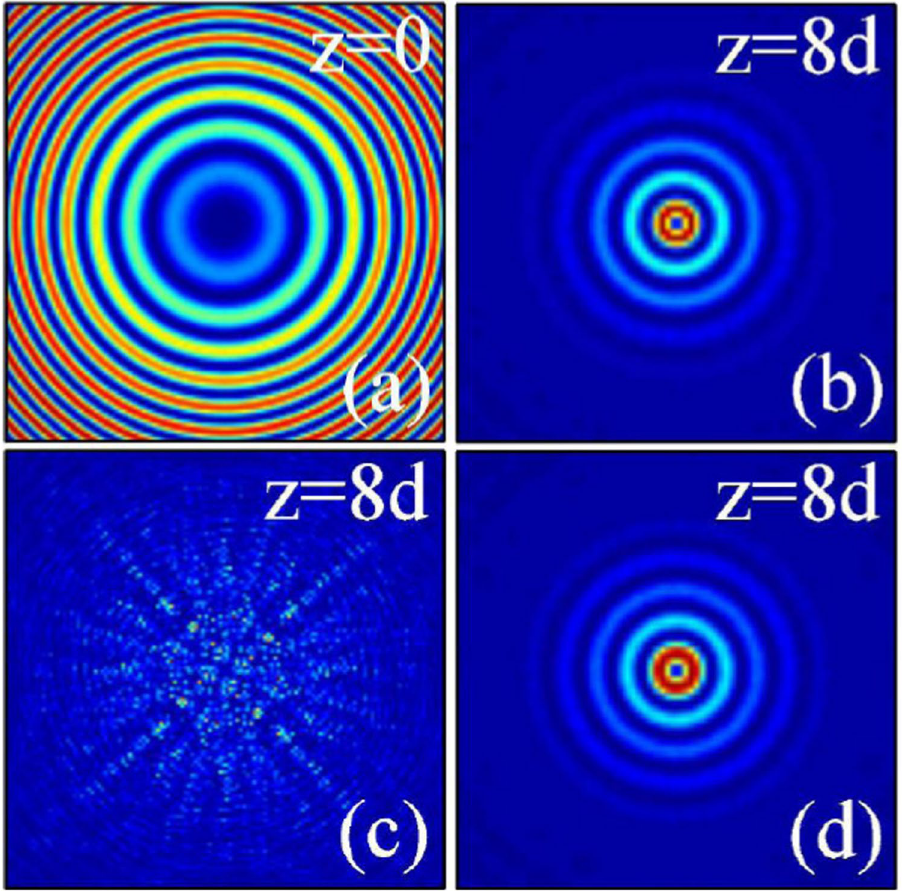
Figure 8. The intensity distributions of inward accelerating abruptly autofocusing Airy beam at different propagation distances in ( a – c ) local ( σ = 0), and ( d ) nonlocal nonlinear media, respectively. The initial parameters are m = 1, r 0 = 0.5, A = 0.5 ( a , b ), and A = 3 ( c , d ). The degree of nonlocality of Fig. 8(d) is σ =